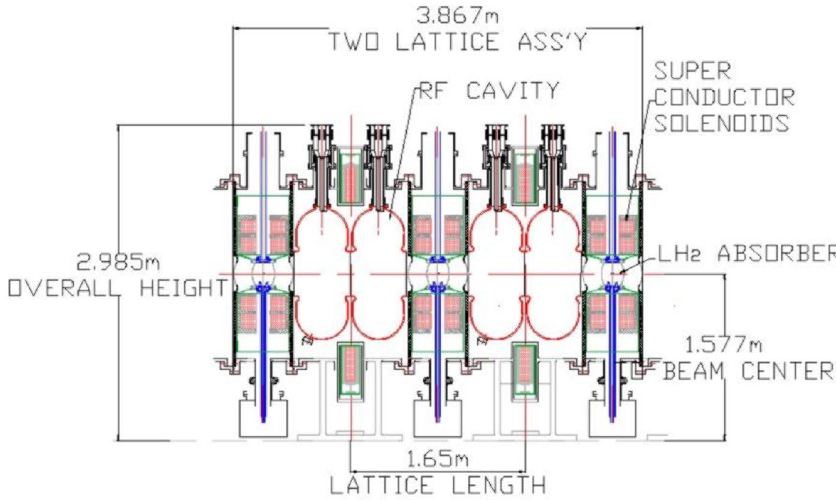
FIG. 18. (Color) Two cells of the 1.65 m cooling lattice.